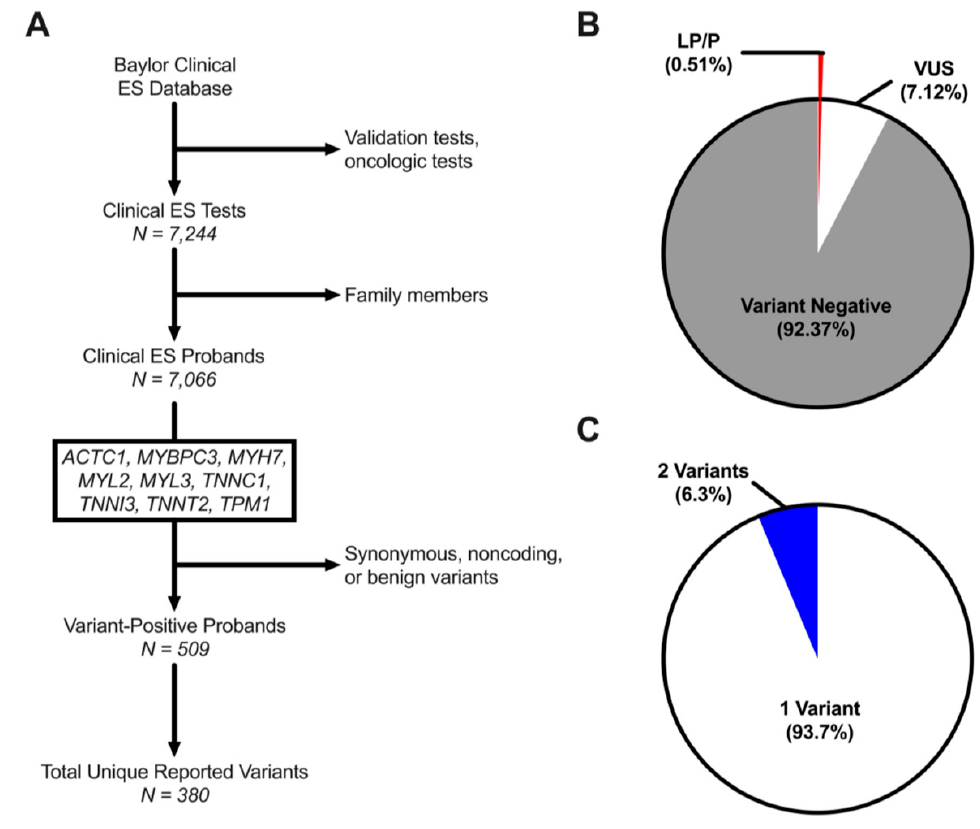
Figure 1. ( A ), Schematic of the study methodology. ( B ), Pie chart of all subjects undergoing ES testing divided into individuals with no HCM gene-associated variant (variant-negative; grey) and individuals who hosted a variant of uncertain significance (VUS; white) or likely pathogenic/pathogenic variants (LP/P, red) according to laboratory interpretation at the time of reporting. ( C ), Pie chart of ES cohort demonstrating variant-positive individuals with a single variant (white) and those with two or more variants (blue). Table 1. Exome sequencing cohort demographics at time of genetic testing.